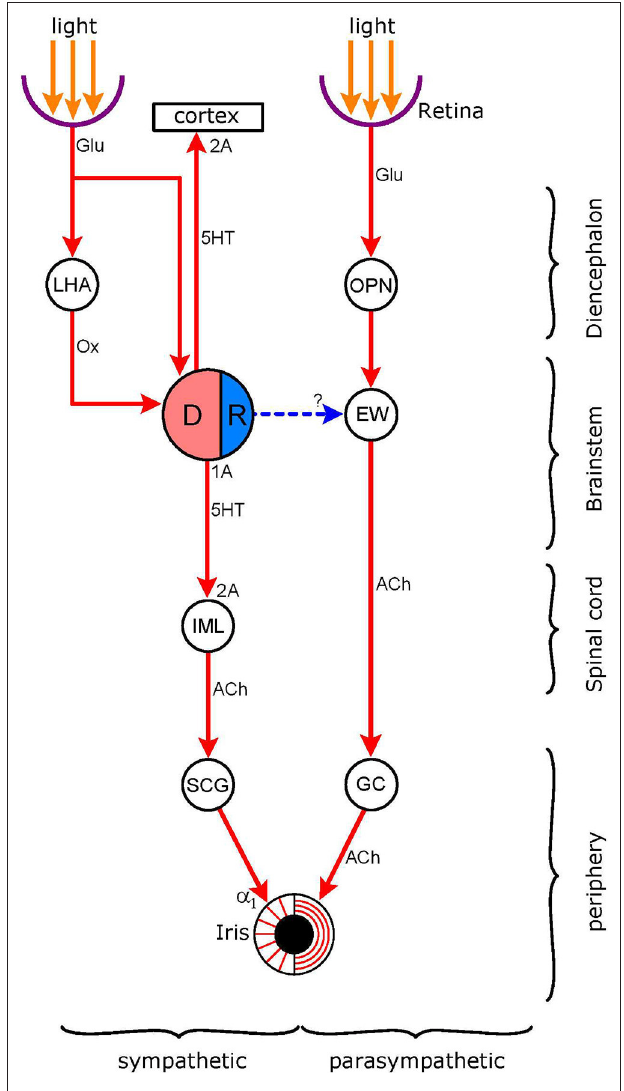
FIGURE 6 | Connections of the light-stimulated serotonergic pathway. Nuclei : DR (DRN in text: dorsal raphe nucleus; pink: excitatory sympathetic premotor neurones, blue: inhibitory parasympathetic premotor neurones); EW (EWN in text: Edinger-Westphal nucleus); OPN (olivary pretectal nucleus); LHA (lateral hypothalamic area), IML (intermedio-lateral column of spinal cord). Ganglia : SCG (superior cervical ganglion), GC (ganglion ciliare). Connections are shown by arrows: red-excitatory; blue-inhibitory (putative). Neurotransmitters : Glu (glutamate); Ox (orexin), 5HT (5-hydroxytryptamine, serotonin), ACh (acetylcholine). Receptors : α 1 -excitatory postgsynaptic adrenoceptors; 2A–excitatory postsynaptic 5-HT 2A receptors; 1A–inhibitory 5-HT 1A autoreceptors. The DR receives both a direct and an indirect input from the retina; the indirect connection involves hypothalamic orexinergic neurones. The possibility of an inhibitory output from the DR to the EW, stimulating inhibitory postsynaptic 5-HT 1A receptors, has been investigated (see 5-HT1A